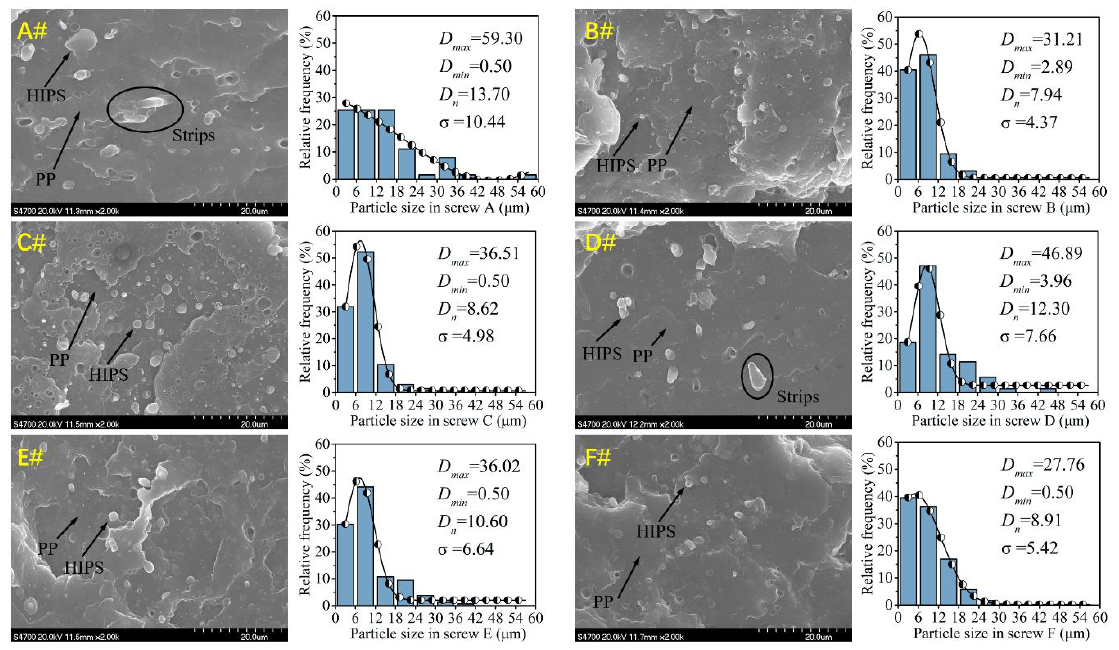
Figure 3. Particle size distribution of dispersed phase for various screws.